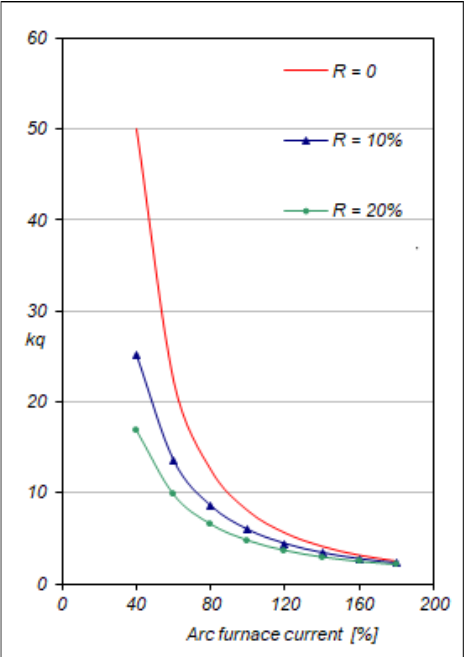
Figure 7. Changes in the k q factor of the power–voltage characteristics for different arc supply resistances, as a function of the current consumed by the arc device.